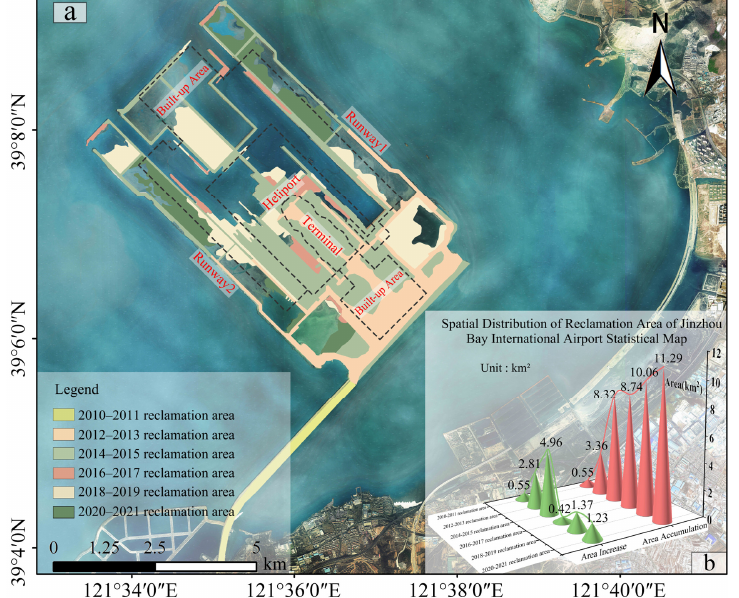
Figure 2. Spatial distribution of different reclamation stages: ( a ) Map of area change of the airport from 2011 to 2021; ( b ) Statistical of the increasement and accumulation of reclamation area. Recla- mation data source: Google Earth.